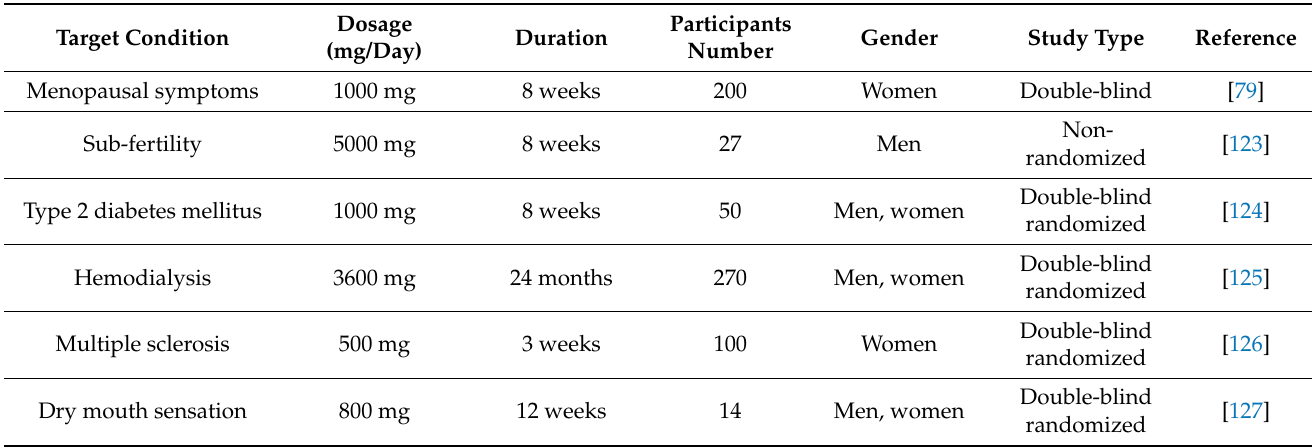
Table 4. Novel clinical trials of RJ